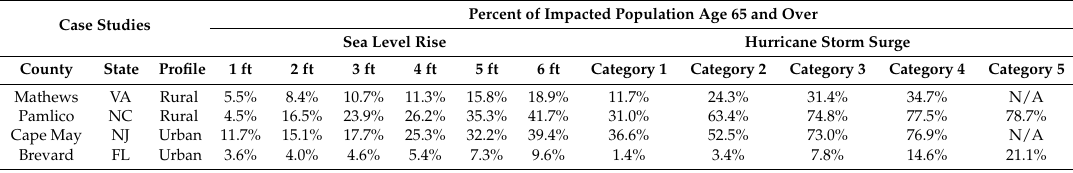
Table 2. Percent of population 65 and over impacted by sea level rise or storm surge in case study